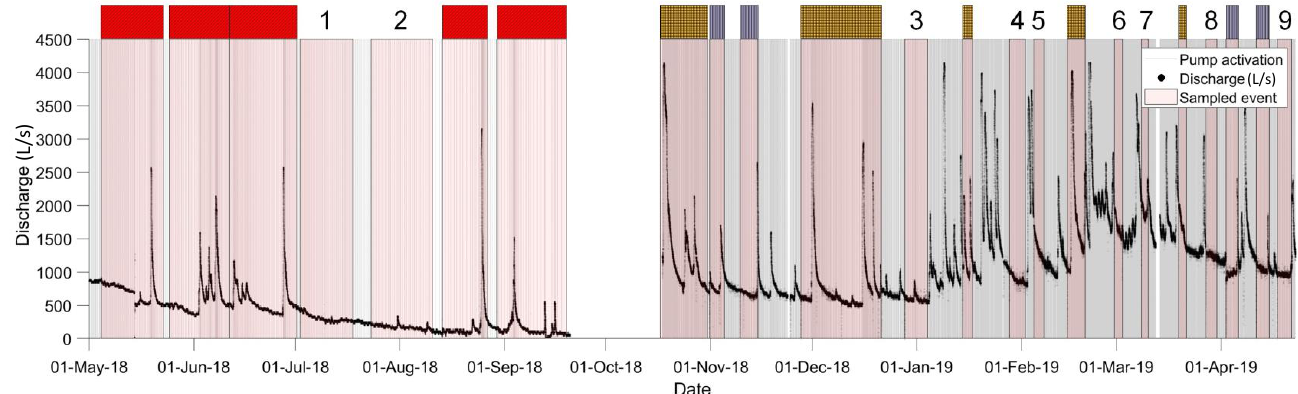
Figure 6. Measurement duration of the LVS station. Only the numbered events were used to assess the TP input.